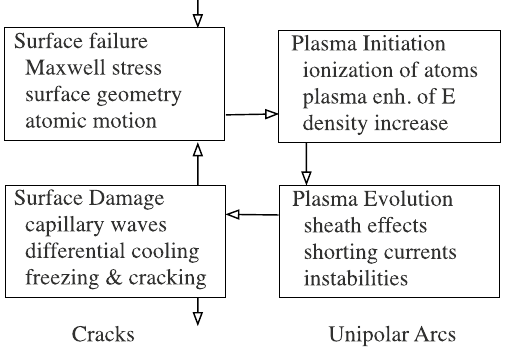
Figure 1. Vacuum arc development involves 4 stages. We consider processes that seem dominant at different stages of the development of the arc, and find that under continued operation the arc follows a life-cycle, where damage from one breakdown event is very likely to produce another. We also find that cracks due to differential cooling and unipolar arc physics explain much of the experimental data we